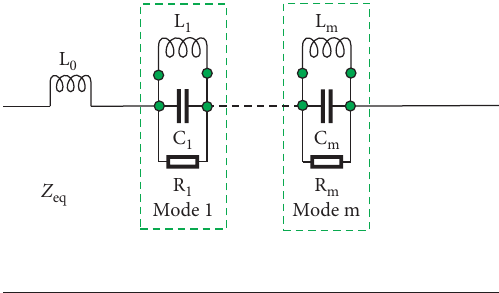
Figure 9: The equivalent circuit of the patch antenna.